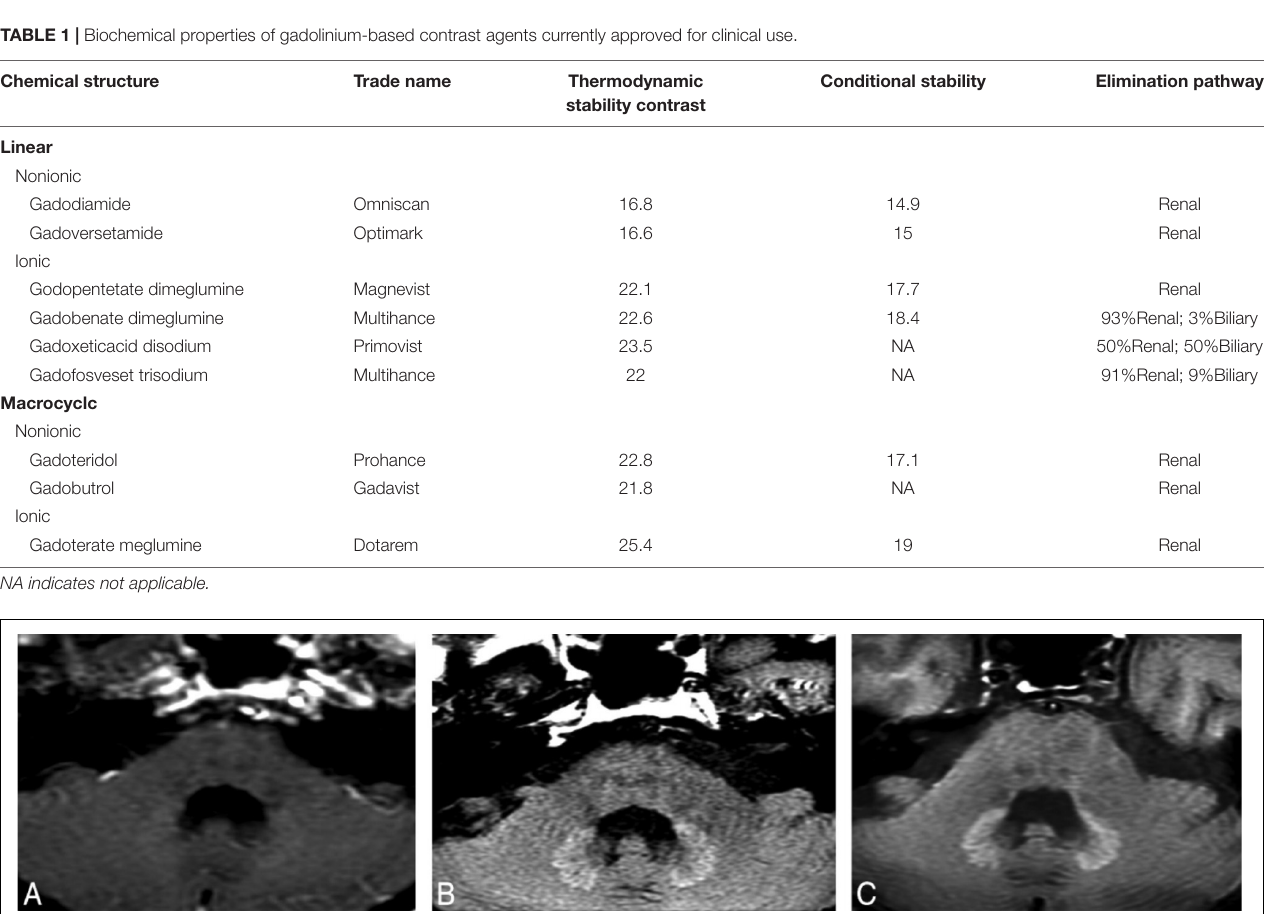
FIGURE 1 | A patient with optical nerve pilocytic astrocytoma who treated with 5400-cGy radiation therapy and underwent 25 times CE-MRI scans show hyperintensity of the DN on unenhanced T1WI. DN initially appears as slightly hyperintense (A) . During the follow-up studies performed at 5 (B) and 8 (C) years after the initial hyperintense appearance of the DN, the signal intensity of the DN become more obvious. Image courtesy of Dr. Mehmet Emin Adin, Russell H. Morgan Department of Radiology, Division of Neuroradiology, Johns Hopkins Medical Institutions, Baltimore, MD. Images and text reproduced from reference 1 with written permission from